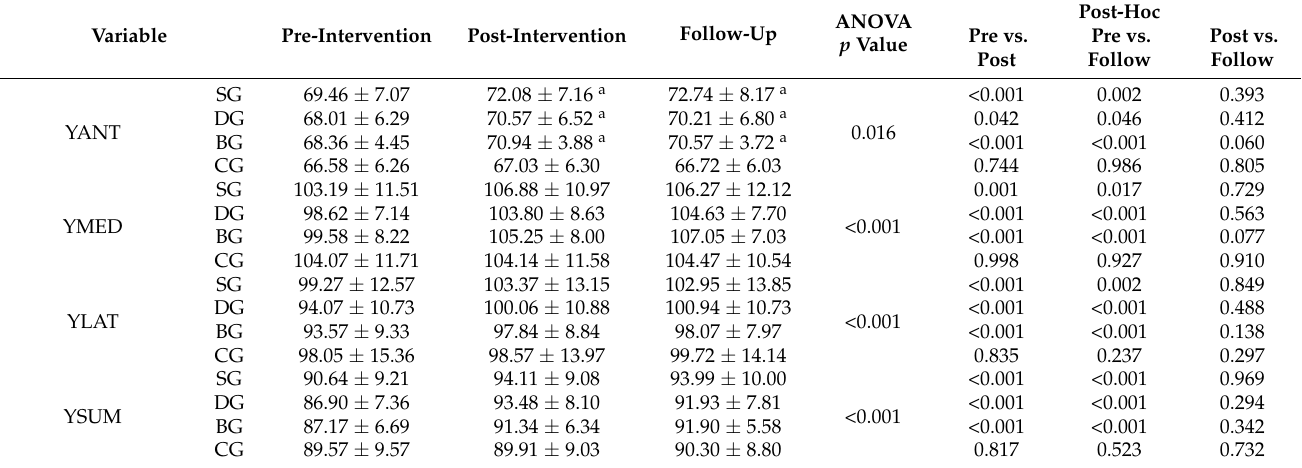
Table 4. Dynamic balance ability.